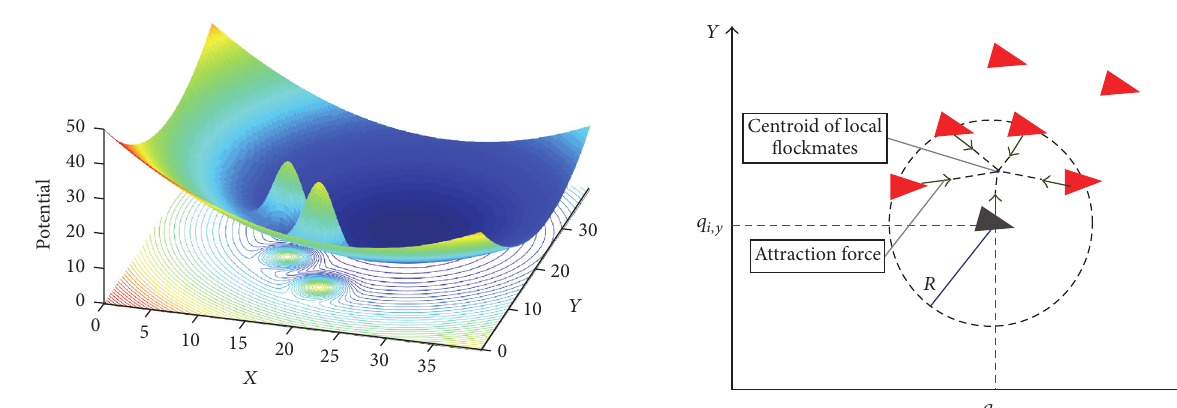
Figure 1: Example of environment model used in this paper. Goal position is represented by the lowest potential value; two hills represent different size of obstacles.